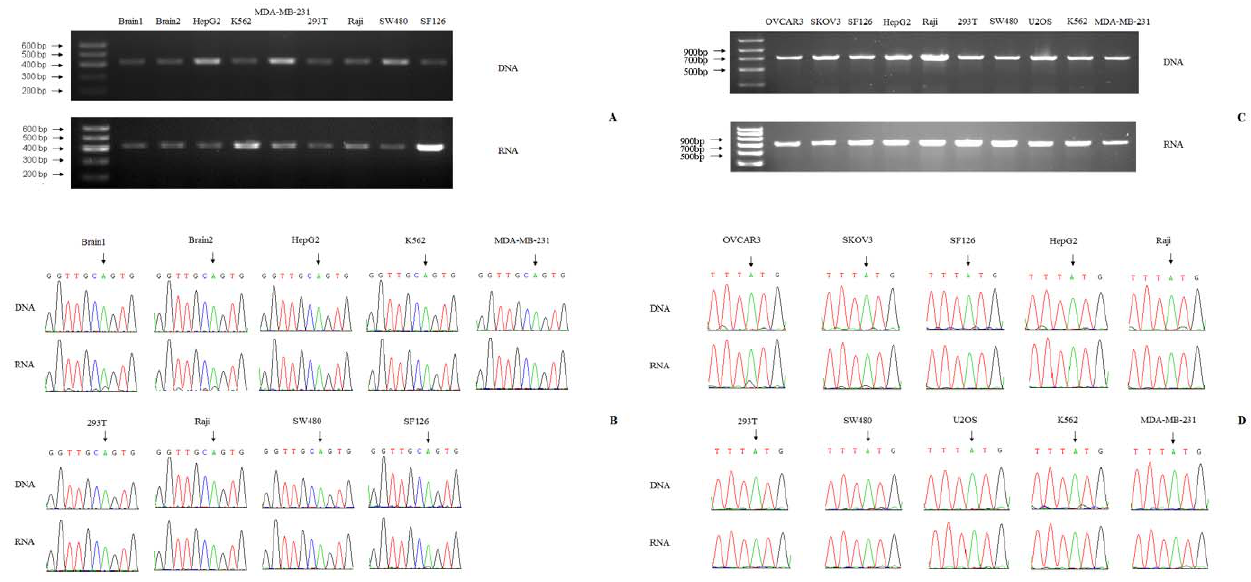
Figure 1. Experimental validation of the predicted brain-specific and ovary-specific RNA editing sites. (A) The up/downstream region of the brain-specific RNA editing site was amplified successfully from cDNAs and gDNA of two adjacent non-cancerous brain tissues, as well as the HepG2, K562, MDA-MB-231, 293T, Raji, SW480 and SF126 cell lines. (B) Sequencing results of paired genomic DNA (control) and cDNA from the same human brain specimens and seven human cell lines. A mixed peak of A and G in the cDNA sample but not in the genomic counterpart indicates the presence of RNA editing in both adjacent non-cancerous brain tissues and the human glioma cell line SF126. (C) The up/downstream region of the ovary-specific RNA editing site was amplified successfully from cDNAs and gDNA of the OVCAR3, SKOV3, SF126, HepG2, Raji, 293T, SW480, U2OS, K562 and MDA-MB-231 cell lines. (D) Sequencing results of paired genomic DNA (control) and cDNA from the same ten human cell lines. A mixed peak of A and G in the cDNA sample but not in the genomic counterpart indicates the presence of RNA editing in the two human ovarian cancer cell lines SKOV3 and OVCAR3.